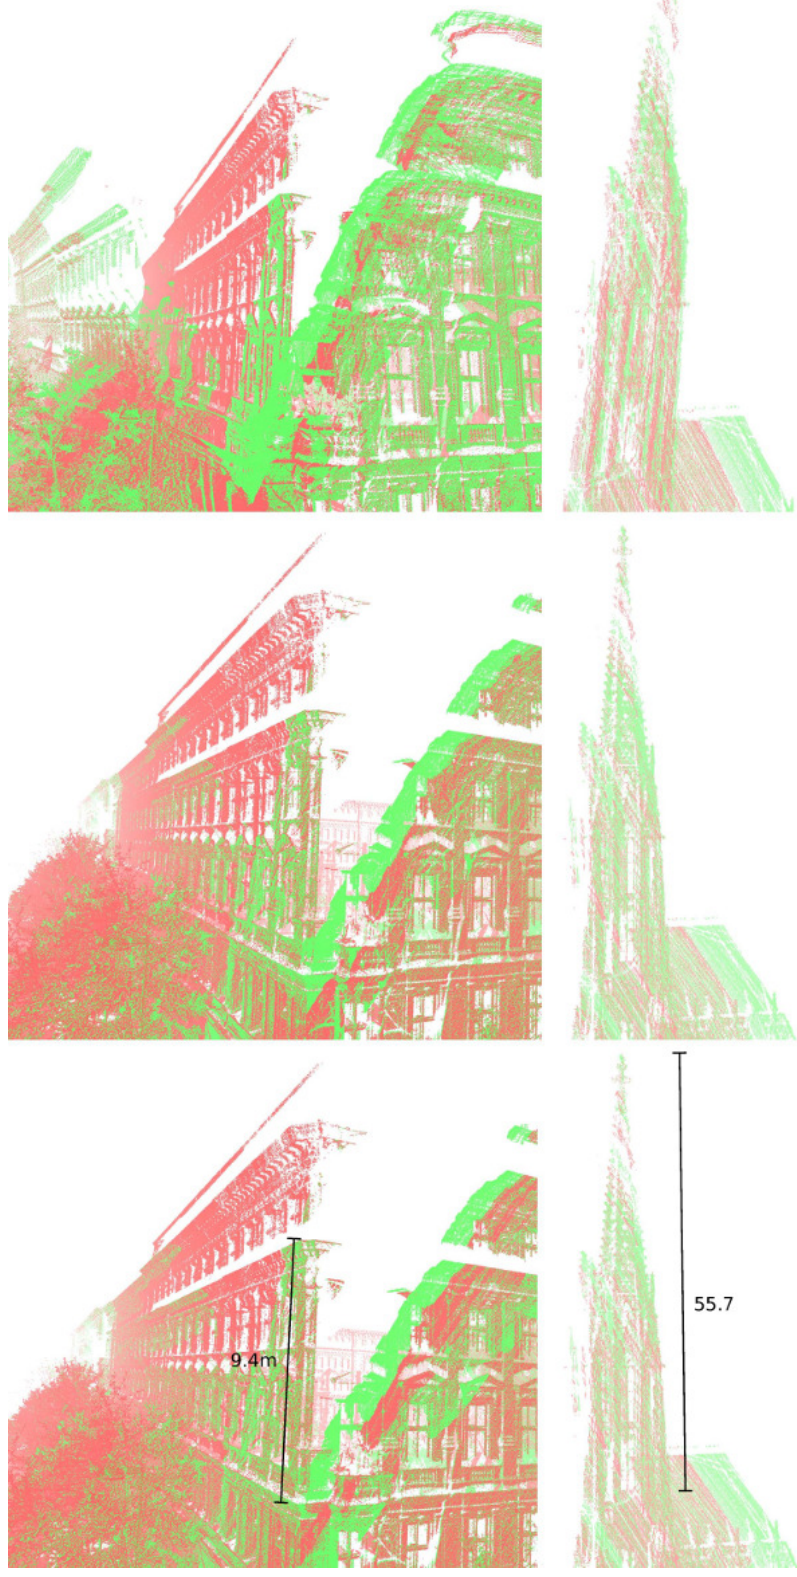
Figure 9. Close-ups of errors ( Top ), calibrated using the proposed algorithm ( Middle ) and the original, as calibrated by RIEGLLaser Measurement Systems ( Bottom ), Vienna dataset. ( Left ) Corner of a building. ( Right ) Top of